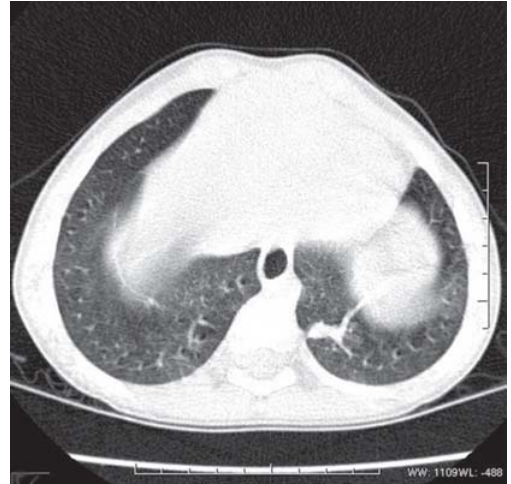
Fig. 5 - Paciente E.R.S., caso 2, sexo masculino, 3 anos de idade e peso de nascimento de 480 gramas. Imagem obtida das bases pulmonares, lesão hipoatenuante em faixa no segmento superior do lobo inferior esquerdo, com aspecto de atelectasia